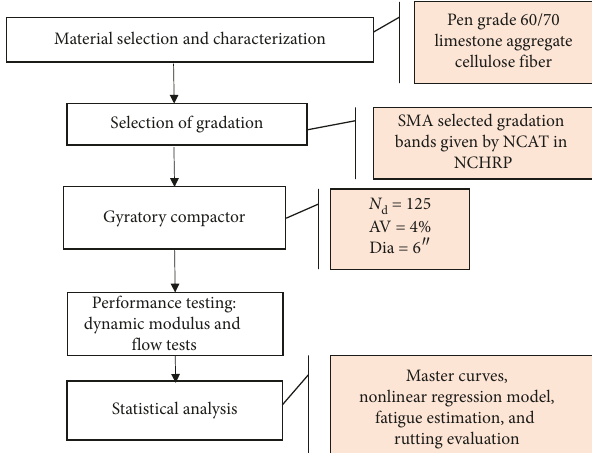
Figure 1: Experimental design of study.